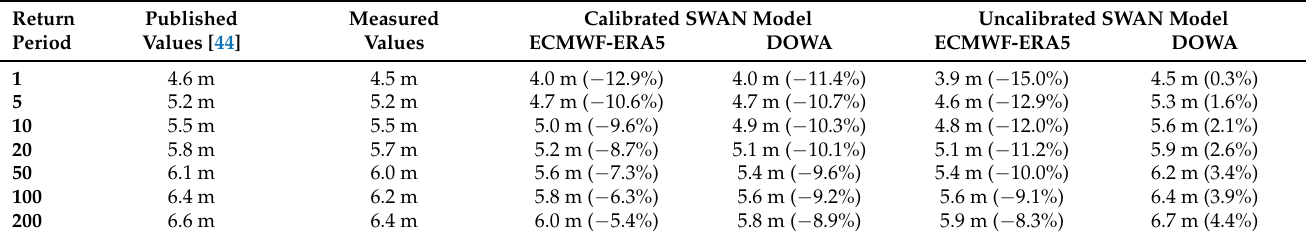
Table 10. Calculated EVA values (and percentage difference between the measured and modelled values) from measurements and SWAN models, computed on the coarse grid (7.5 km), compared to published values for deep water station at